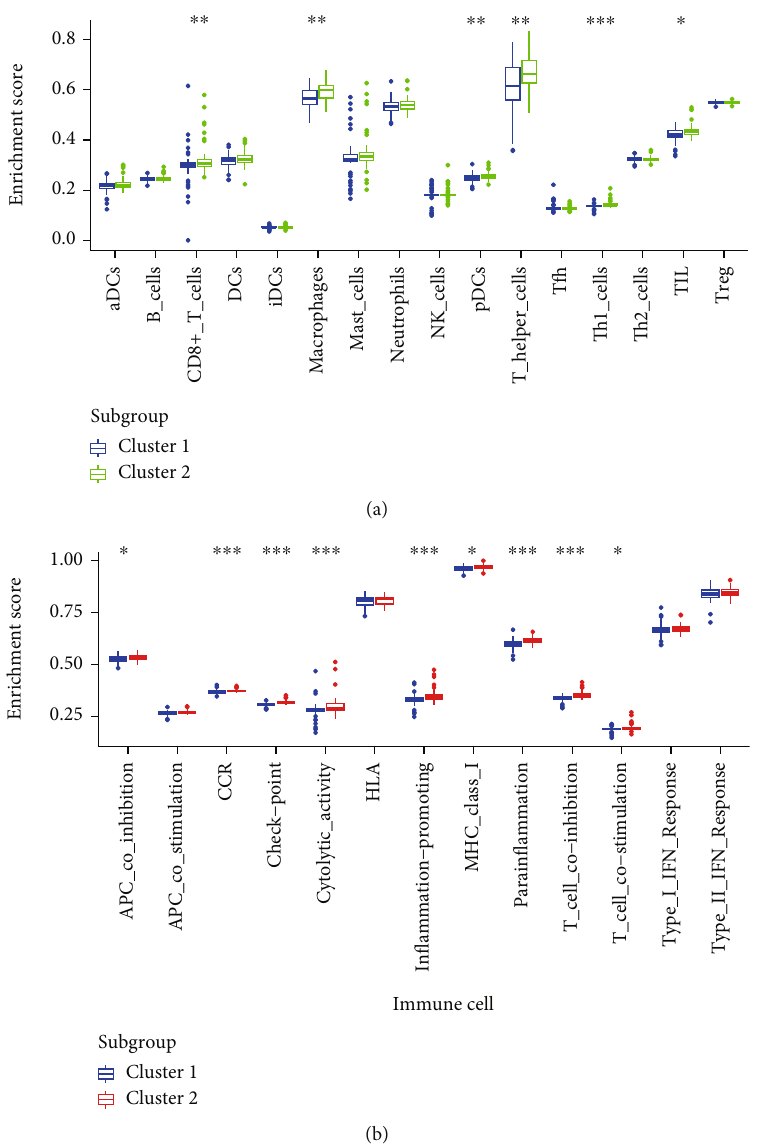
Figure 3: Immune in fi ltration in adipogenesis subgroups. (a) Abundance of 16 in fi ltrating immune cells in the two adipogenesis subgroups. (b) Di ff erences of 13 in fi ltrating immune processes in the two adipogenesis subgroups. ( ∗ p < 0 : 05 , ∗∗ p < 0 : 01 , and ∗∗∗ p < 0 : 001